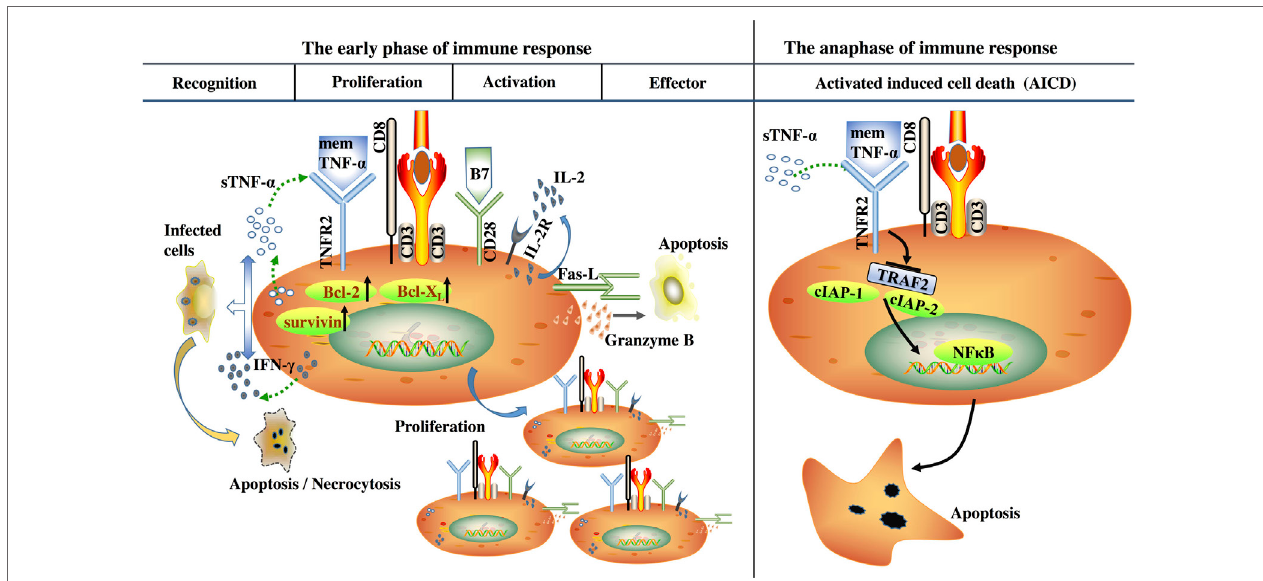
FiGURe 2 | Tumor necrosis factor (TNF) receptor type II (TNFR2) modulates the process of immune response mediated by CD8 + effector T cells (Teffs). In the early phase of immune response, TNFR2 is a CD8 + Teff costimulatory molecule for IL-2, survivin, Bcl-2, and Bcl-x L induction to promote CD8 + Teffs survival, proliferation, and activation and involve in controlling the cell fate during TCR/CD28-mediated stimulation. TNFR2 is essential for the production of IFN- γ and TNF- α in CD8 + Teffs to promote antigen clearance. Additionally, TNFR2 is also required for CD8 + Teffs to upregulate Fas-L and granzyme B to enhance their cytotoxic activity. However, in the anaphase of immune response, TNFR2 can induce activated CD8 + T cells programmed cell death to terminate the immune response via the degradation of a pro-survival signal—TRAF2, which is required for the recruitment of cellular inhibitor of apoptosis proteins cIAP-1 and cIAP-2 to the TNFR2 signaling complex and activates nuclear factor- κ